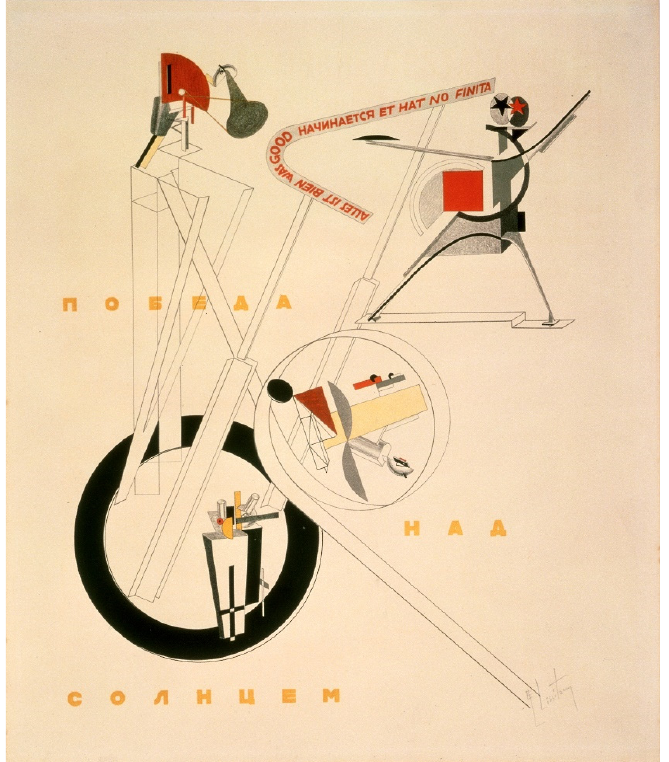
Figure 3. El Lissitzky, ‘Schaumaschinerie’ (Viewing Machine), lithograph for the ‘Figurinnenmappe’, 1923. Van Abbemuseum. Photo: Peter